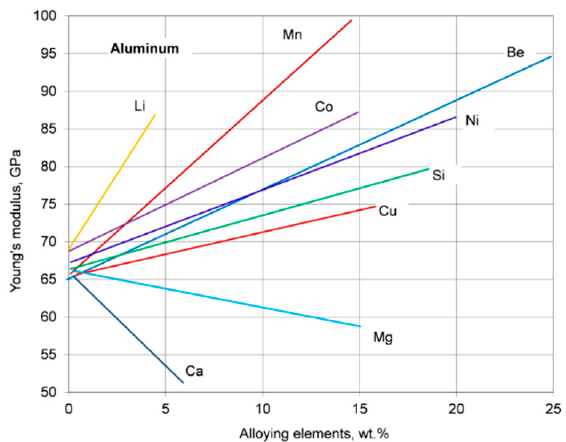
Figure 6. E ff ect of solute additions on the elastic modulus of aluminum alloys; created based on the work in [19].